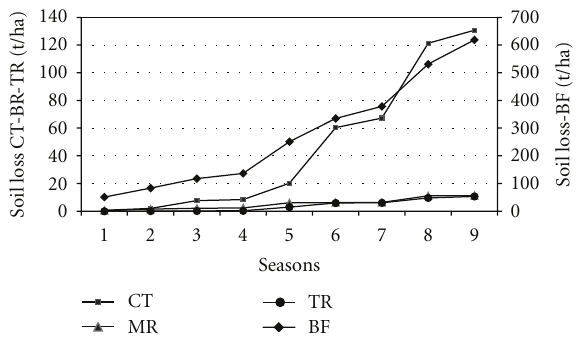
Figure 2: Monthly rainfall distribution over nine seasons at Makoholi Contill site.